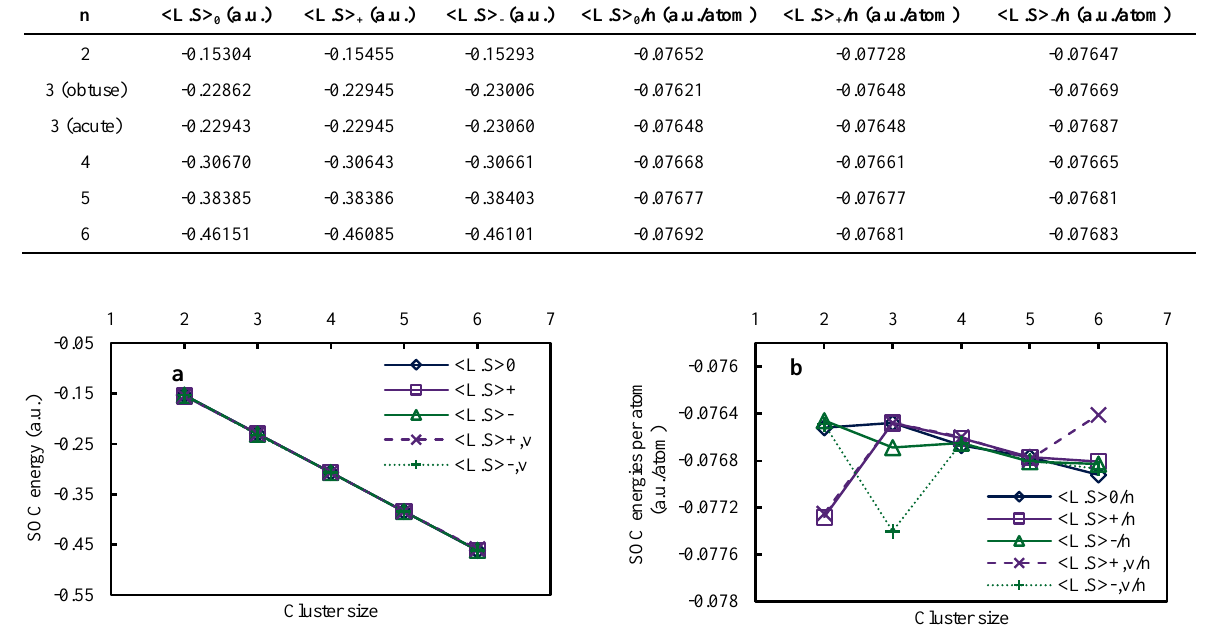
Table 8. Spin-orbit coupling energies of the neutral <L.S> 0 , cationic <L.S> + , and anionic <L.S> - gold clusters at the DKH2- B3P86/DZP-DKH//DKHSO-GHF/DZP-DKH level. <L.S> 0 , <L.S> + , and <L.S> - are the SOC energies at the optimized geometries of neutral, cationic and anionic gold clusters, respectively.